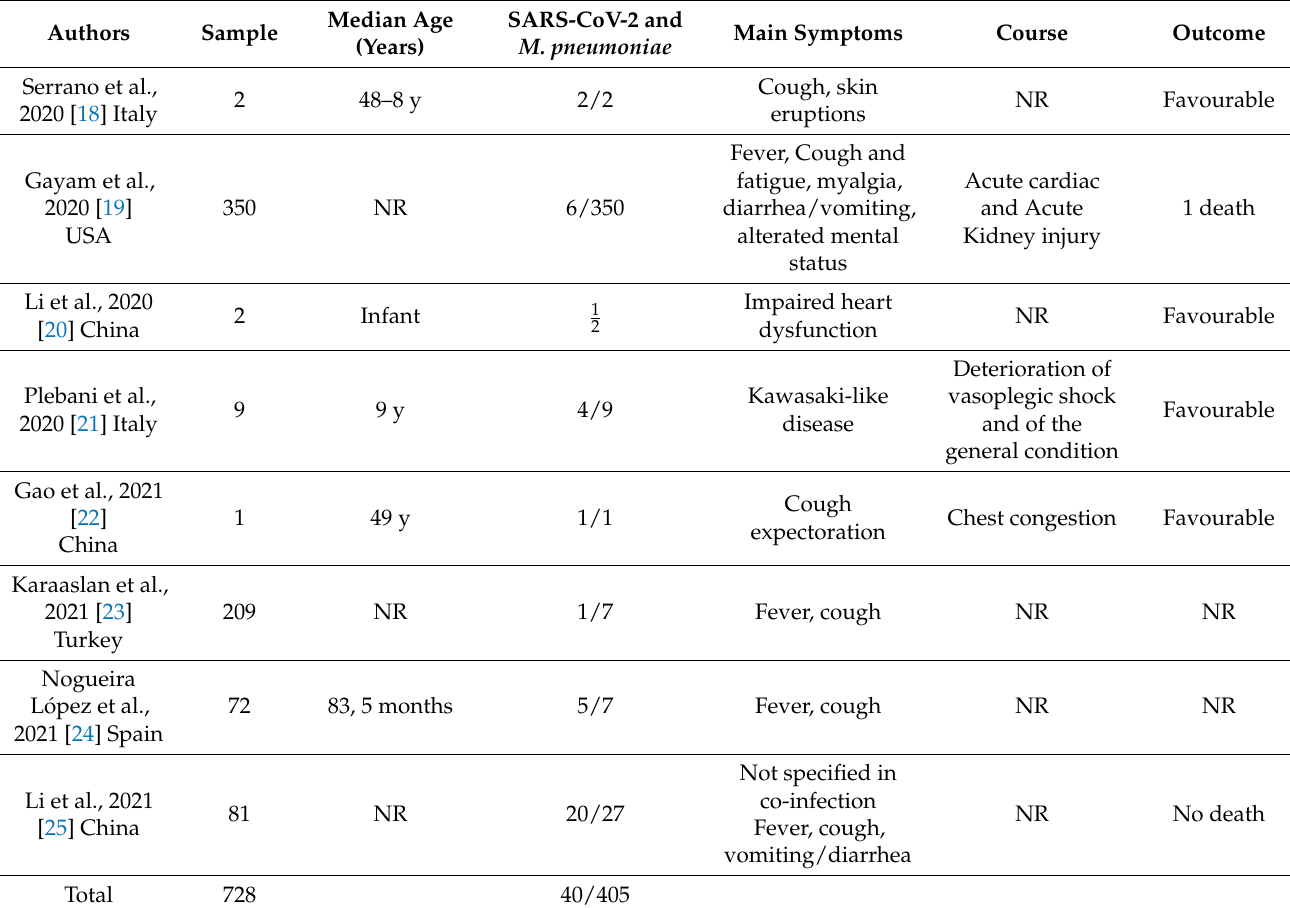
Table 2. SARS-CoV-2 and Mycoplasma pneumoniae